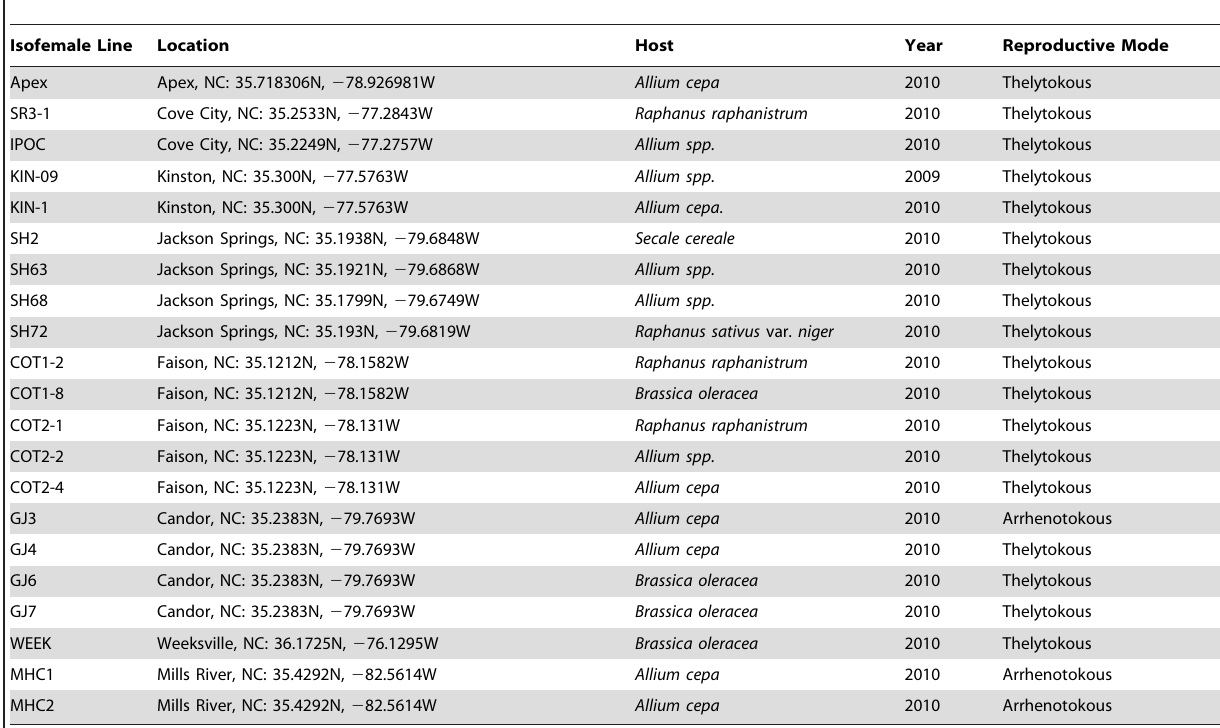
Table 1. Collection information for Thrips tabaci isofemale lines used in the transmission experiments.